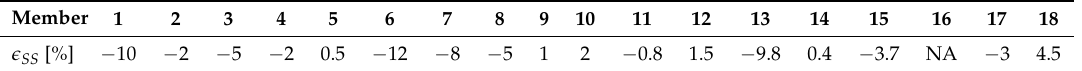
Table 4. Change (cid:101) SS in self-sufficiency between July 2019 and June 2020 for each community member, in